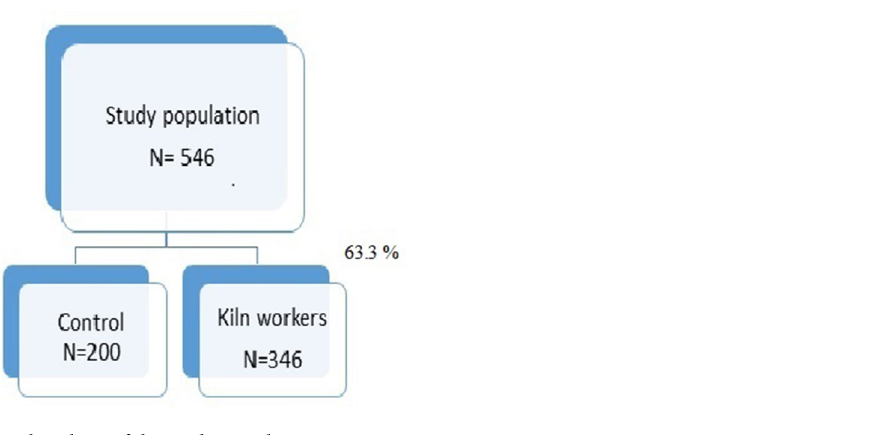
Figure 1. Flowchart of the study